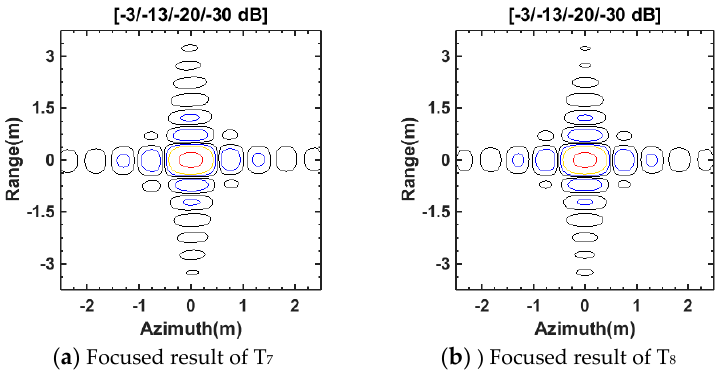
Figure 12. Focused point target results of T 4 , T 5 , and T 6 : ( a ) focused result of T 4 ; ( b ) focused result of T 5 ; and ( c ) focused result of T 6 .